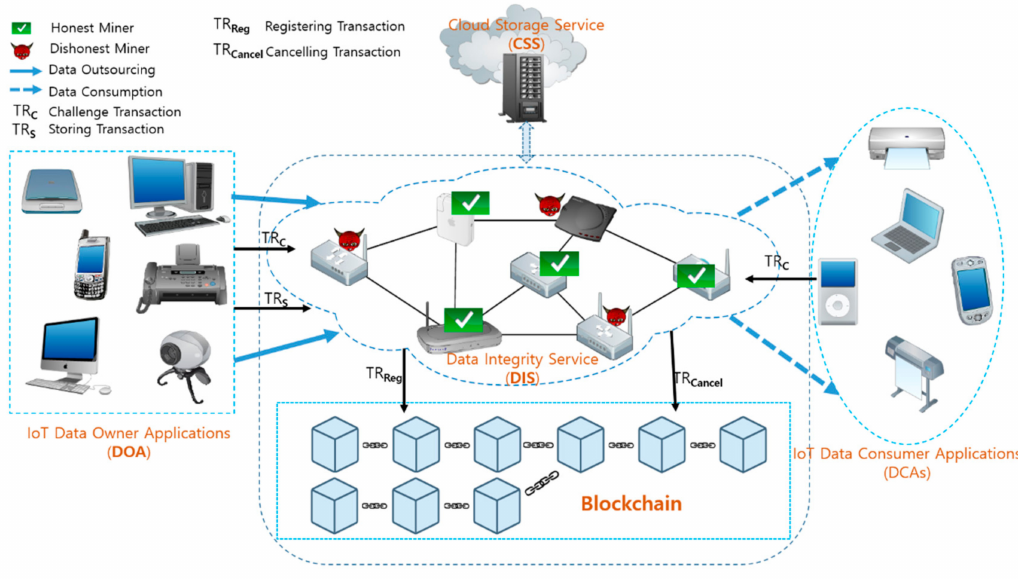
Figure 7. Framework for data integrity using